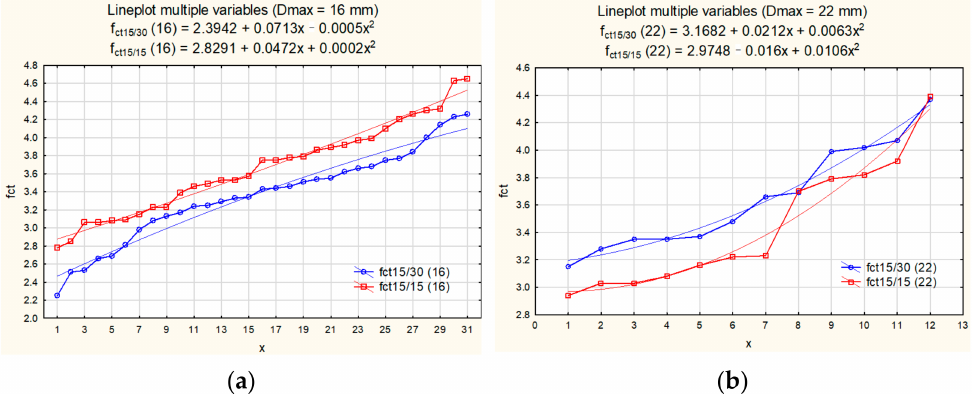
Figure 8. Line plots of variables f ct,sp15/30 and f ct15/15 with the regression functions: ( a ) for series with D max = 16 mm, ( b ) for series with D max = 22